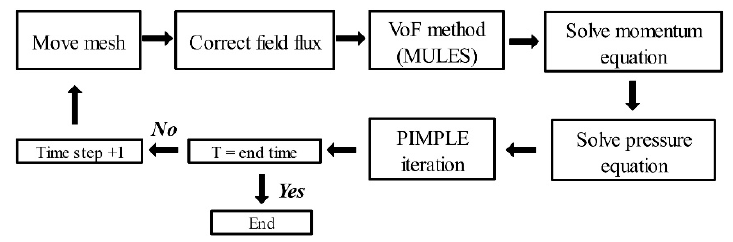
Figure 1. Solution process of the interFoam solver.